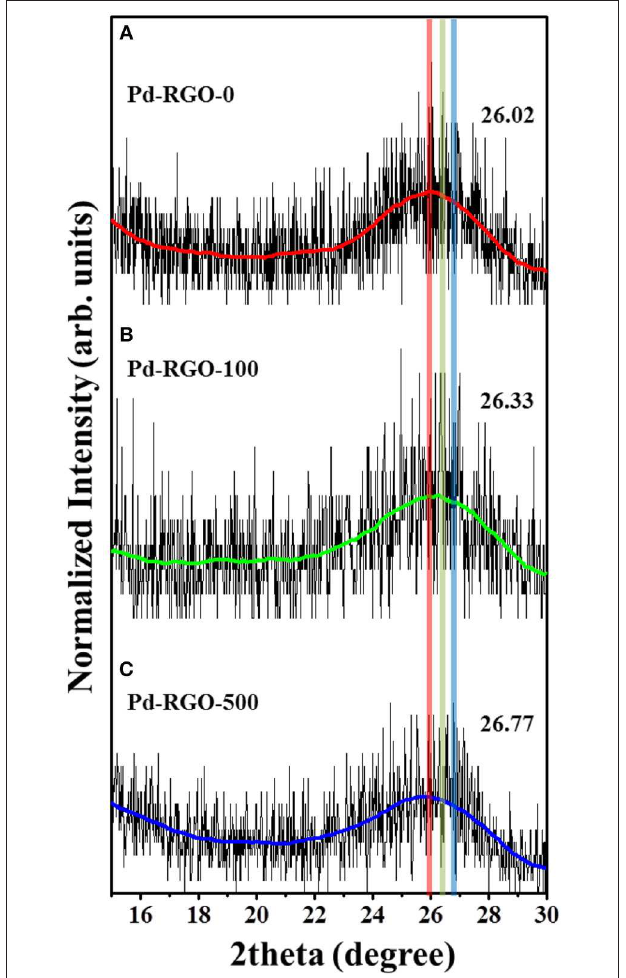
FIGURE 2 | XRD patterns of (A) Pd-RGO,-0 (B) Pd-RGO-100, and (C)